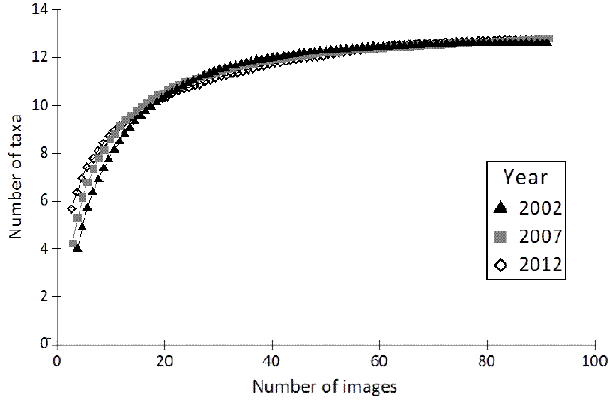
Fig. 3. Permutated species-accumulation curves based on documen- tation of the 11 most recognizable species at HG I. An asymptote appears to be reached in each